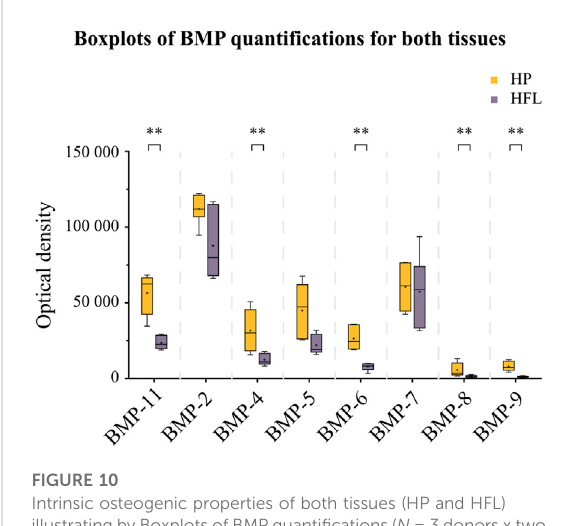
FIGURE 10 Intrinsic osteogenic properties of both tissues (HP and HFL) illustrating by Boxplots of BMP quanti fi cations ( N = 3 donors x two detecting plots per donor leading to n = 6 optical densities analyzed for each tissue). HP: human periosteum, HFL: human fascia lata, BMP: bone morphogenetic protein. +: mean, ** p <